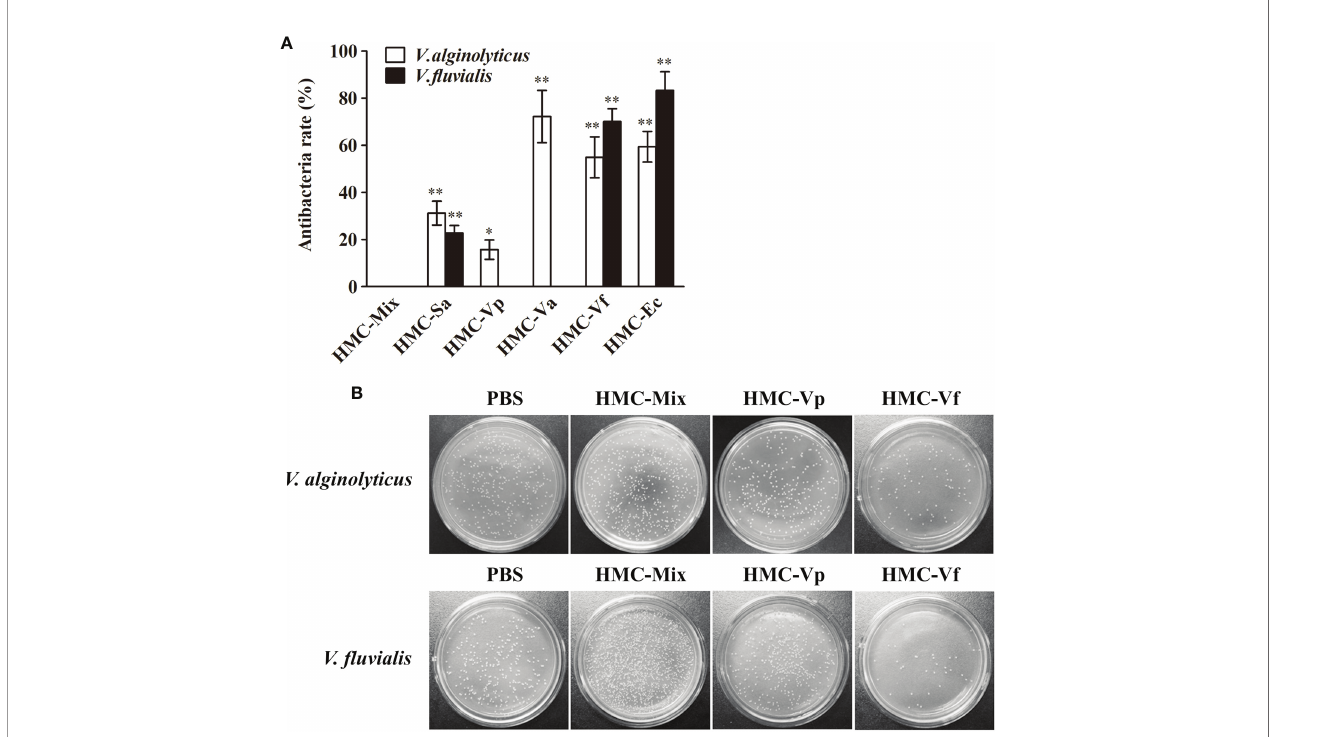
FIGURE 4 | Antibacterial activities analysis of six bacteria-binding hemocyanin fractions from L. vannamei . (A) Comparison of antibacterial activities of 125 m g/ml HMC-Mix, HMC-Sa, HMC-Vp, HMC-Va, HMC-Vf, and HMC-Ec to V. alginolyticus and V. fl uvialis , respectively. Data represent mean ± SD of at least three separate experiments. * p < 0.05, ** p < 0.01. (B) Bacterial colonies of V. alginolyticus and V. fl uvialis in Petri dishes treated with 50 m l HMC-Mix, HMC-Vp, HMC-Vf (125 m g/ml for each), respectively, 0.01 M pH 7.4 PBS as negative